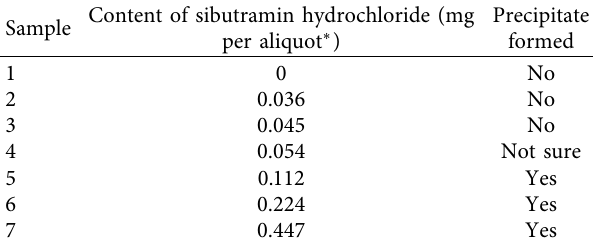
Table 9: The determination of adjusted detection